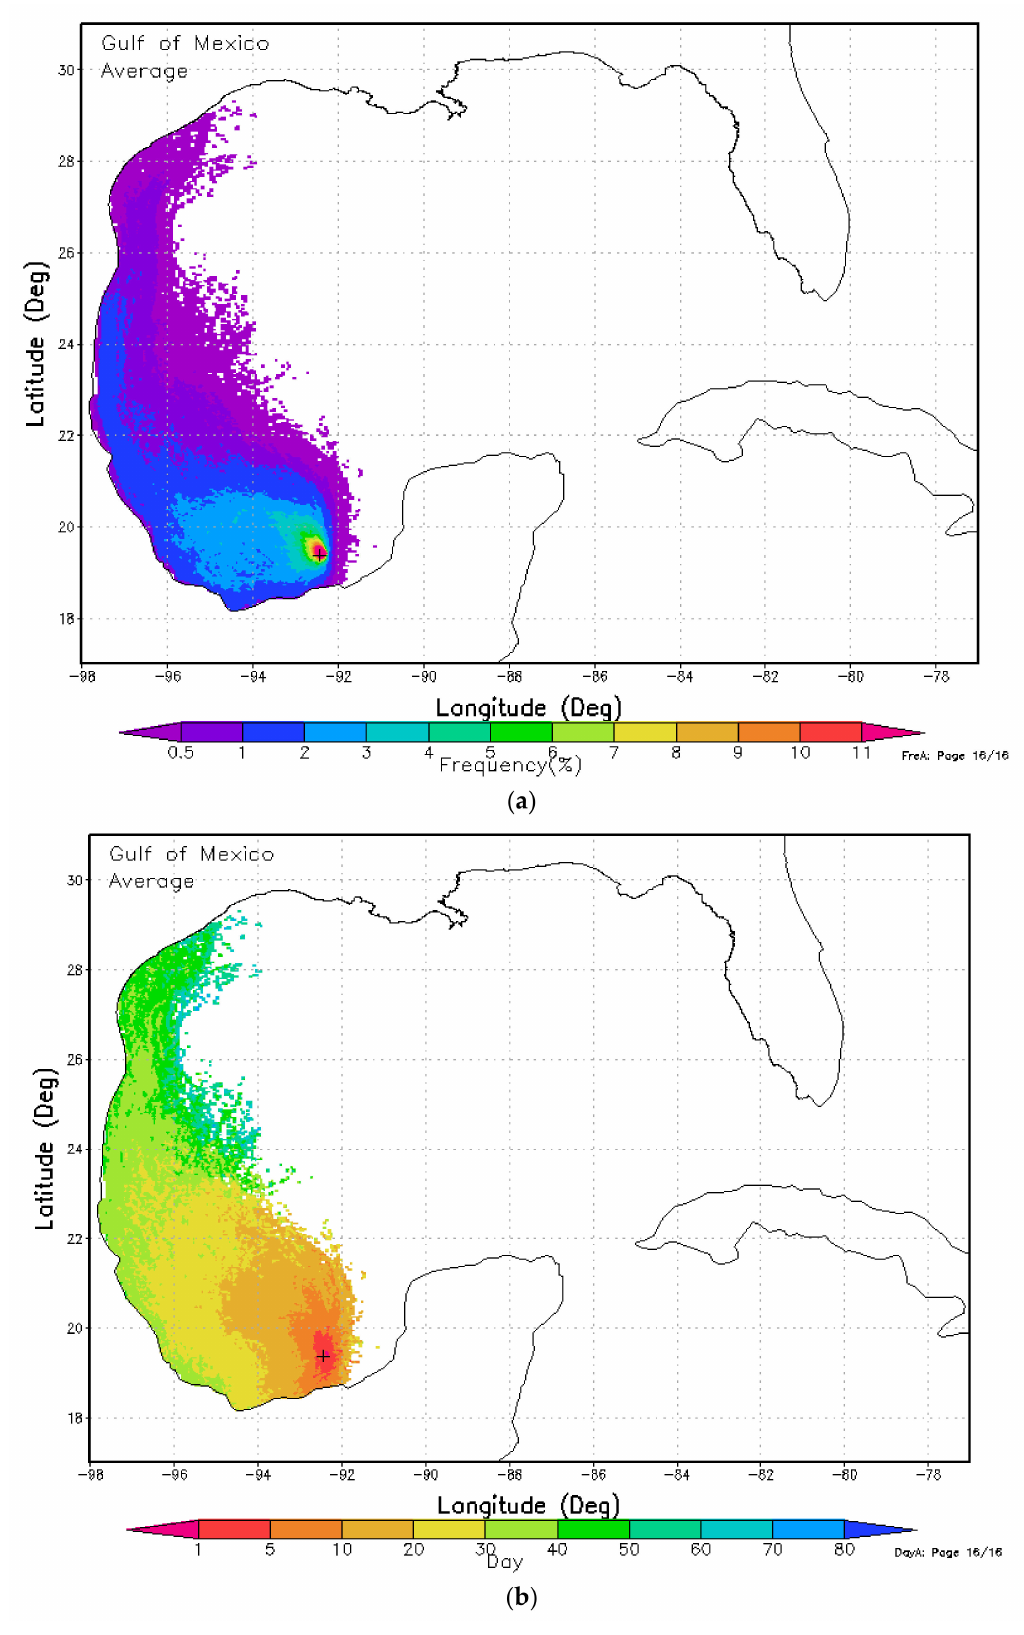
Figure 8. ( a ) Probability of contact with oil spilled from the Ixtoc I location (shown with a + sign), averaged over 15 years (1993–2007). ( b ) Time of contact with oil spilled from the Ixtoc I location (shown with a + sign), averaged over 15 years